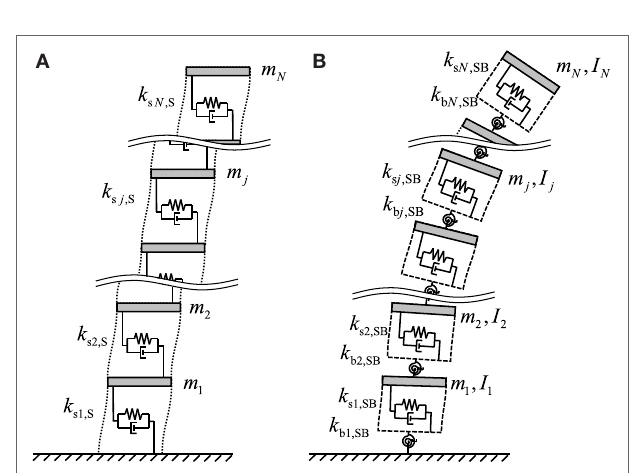
FIGURE 6 | Building models: (A) shear model and (B) shear-bending model .